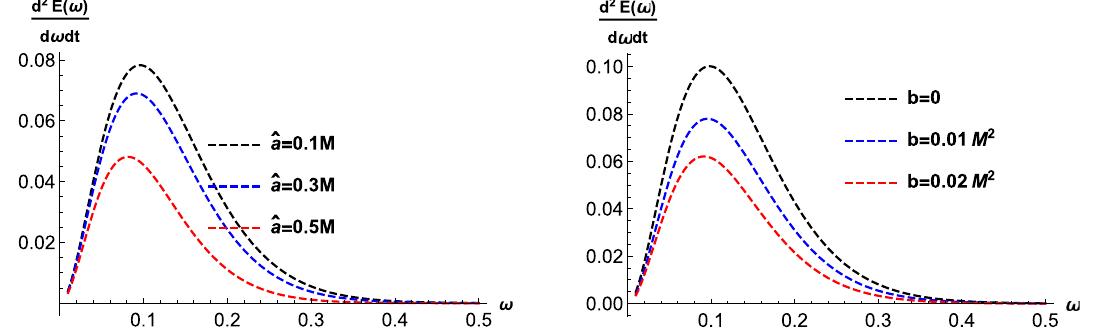
Fig. 18 The left panel gives variation of emission rate against ω for various values of ˆ a with b = 0 . 01 M 2 and (cid:2) = 0 . 3. The right panel gives variation of emission rate against ω for various values of b with a = 0 . 1 M and (cid:2) = 0 . 3